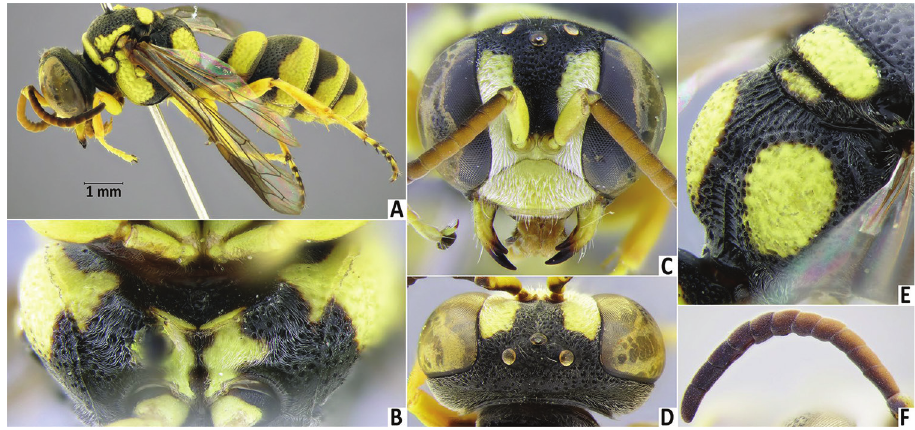
Figure 2. Hoplisoides flavescens Mokrousov, sp. nov., male, paratype: A habitus, lateral view B metasoma, ventral view C head, frontal view D head, dorsal view E scutellum, metanotum and propodeum, poste- rolateral view F antenna, dorsal